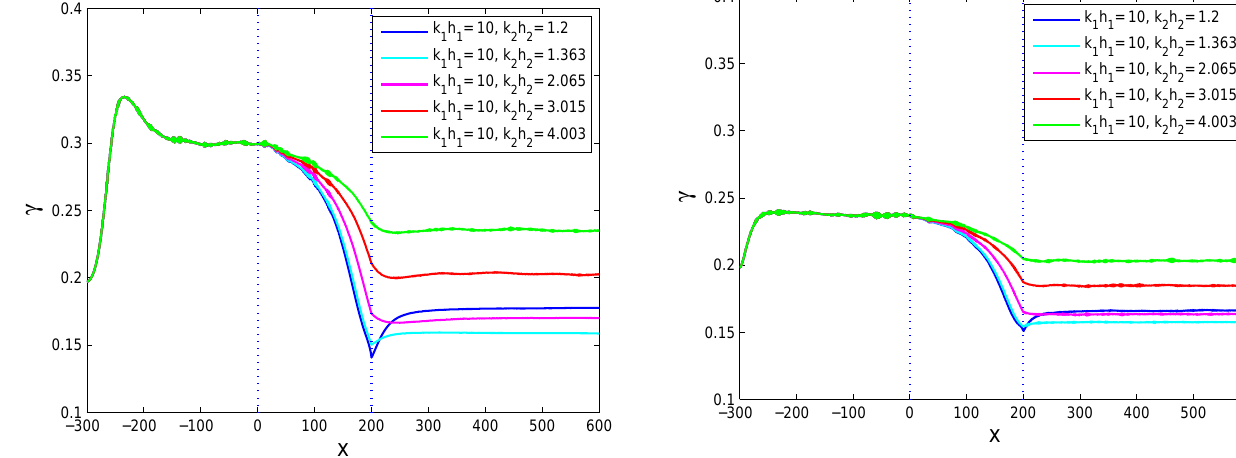
Fig. 9. Skewness as a function of x for k 1 h 1 = 10, k 2 h 2 = 1.2, 1.363, 2.065, 3.015, 4.003 and initial BFI = 1 . 0.